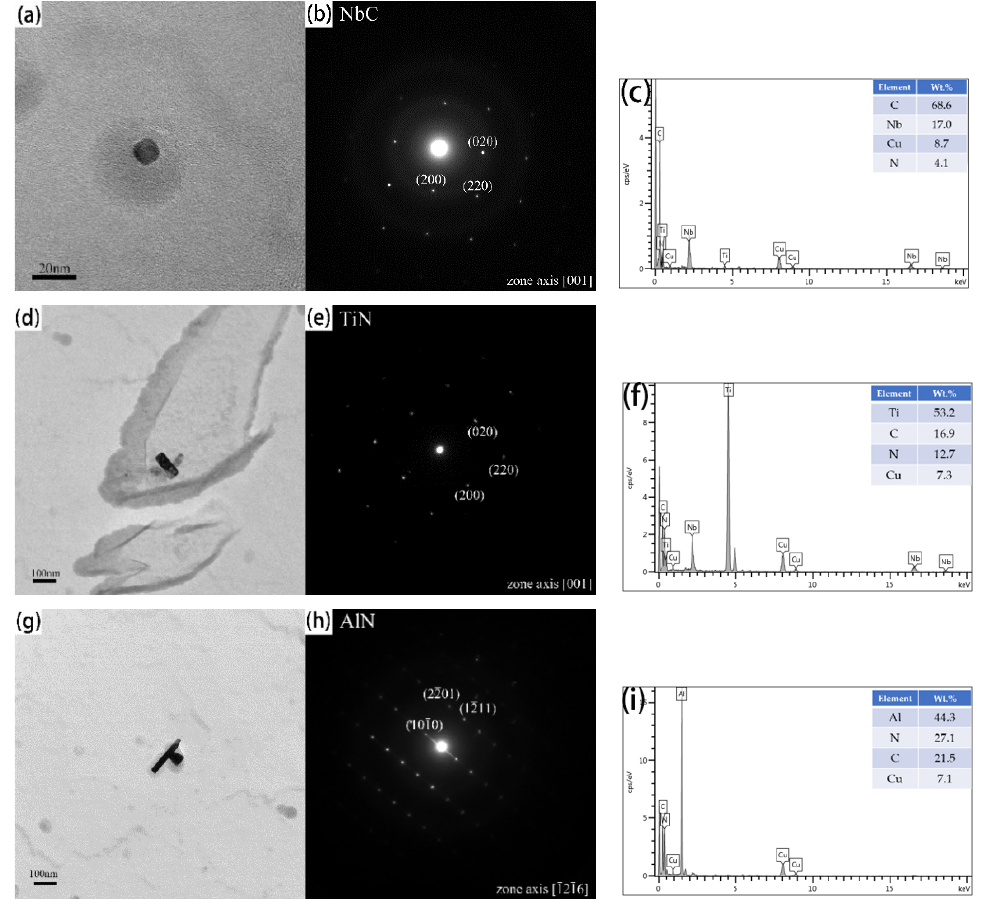
Figure 4. TEM micrographs of three types of precipitates found in the carbon extraction replicas, associated with selected area diffraction patterns and EDS analysis. ( a – c ) NbC, ( d – f ) TiN, ( g – i ) AlN.